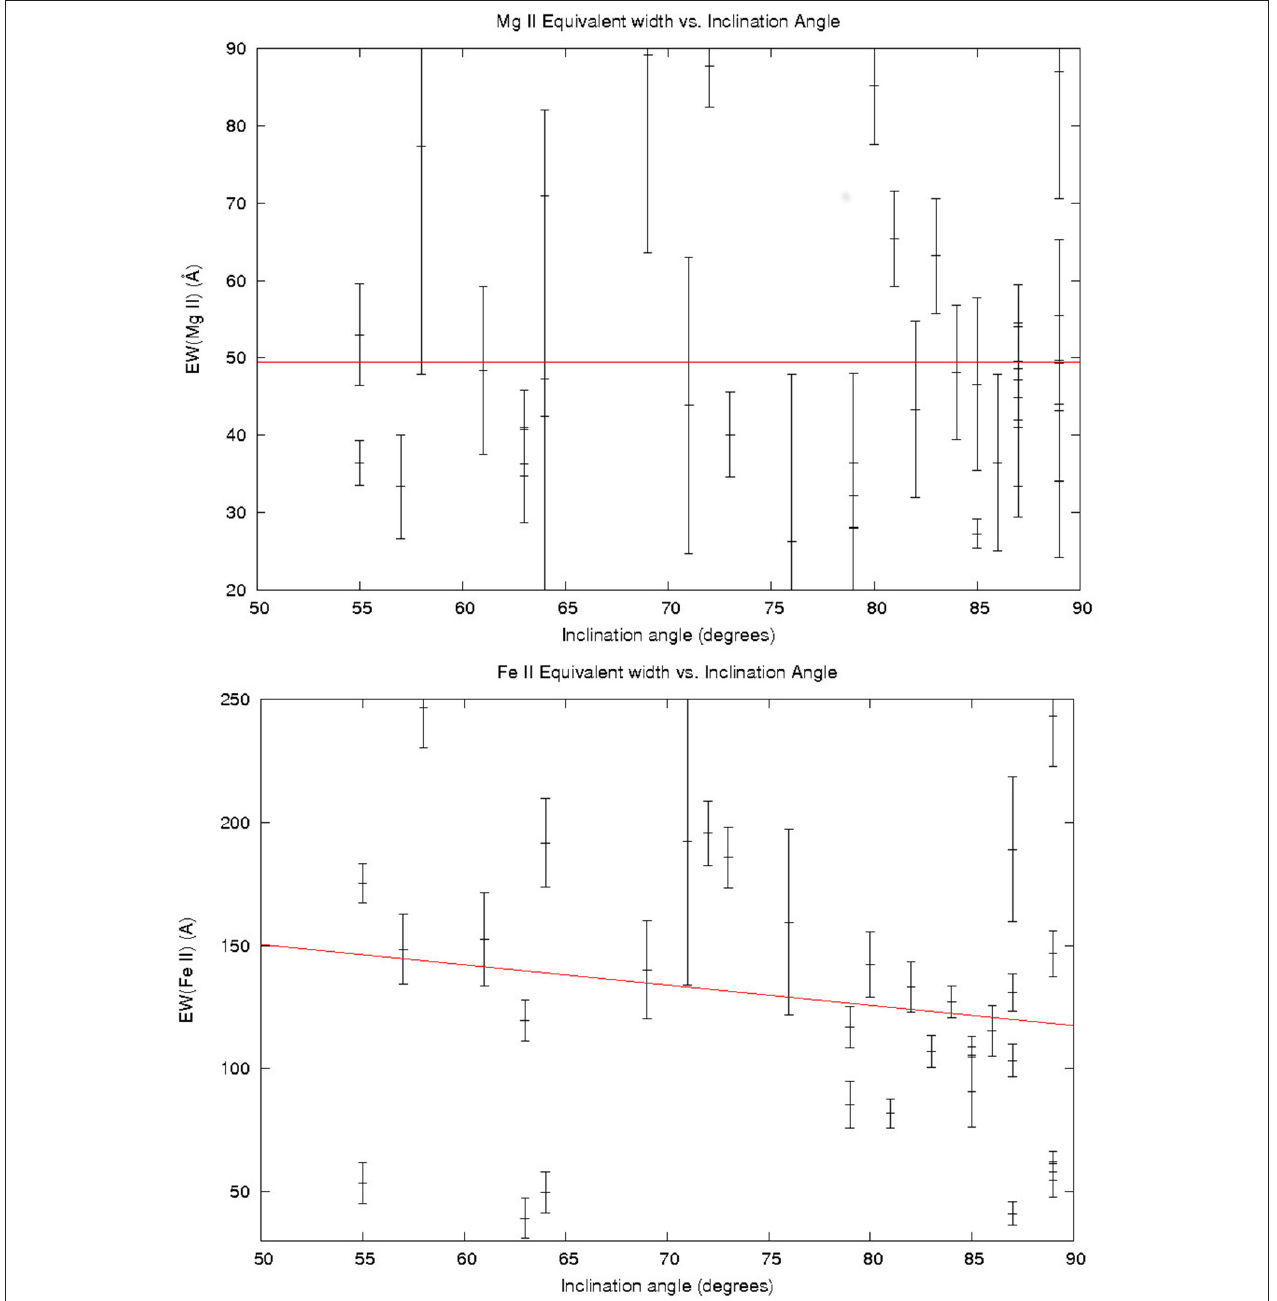
FIGURE 3 | Quasar Mg II EW (top panel) and Fe II EW (bottom panel) plotted against inclination angle along with the respective best-fitting trend lines (red). Vertical bars at each point indicate EW 1 σ error range for each object. For Fe II the correlation likelihood is higher (86%) when compared to that of Mg II (38%).